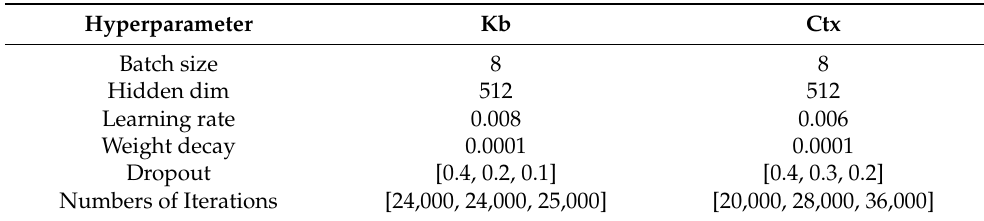
Table 1. The parameters of experiments. (Kb represents the model of introducing external knowledge, Ctx represents the model of using visual contextual loss).